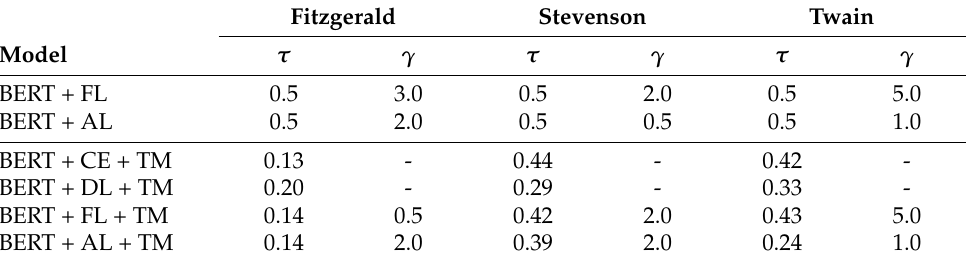
Table 3. Hyperparameters tuned through grid search on validation data. Value of γ is a hyperparam- eter for focal loss and anchor loss. Value of τ is the decision threshold. Value of τ for models with threshold moving could be tuned between 0 and 0.5 in 0.01 increments. However, values for BERT + FL and BERT + AL were fixed at 0.5 because threshold moving was not introduced in these models. Fitzgerald Stevenson Twain